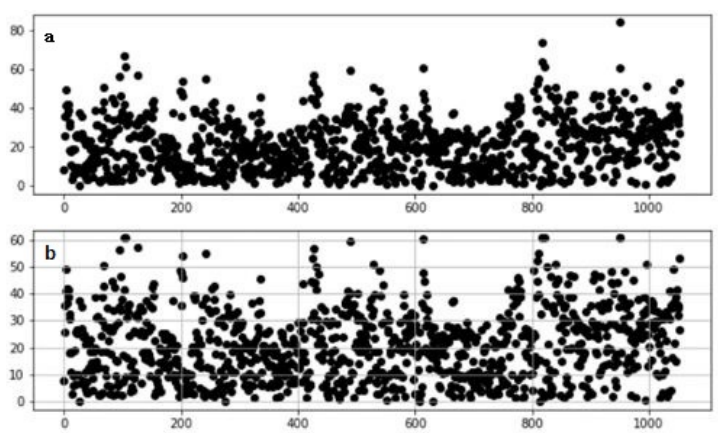
Figure 9. Abnormal point correction: ( a ) Comparison results before; ( b ) Comparison results after.